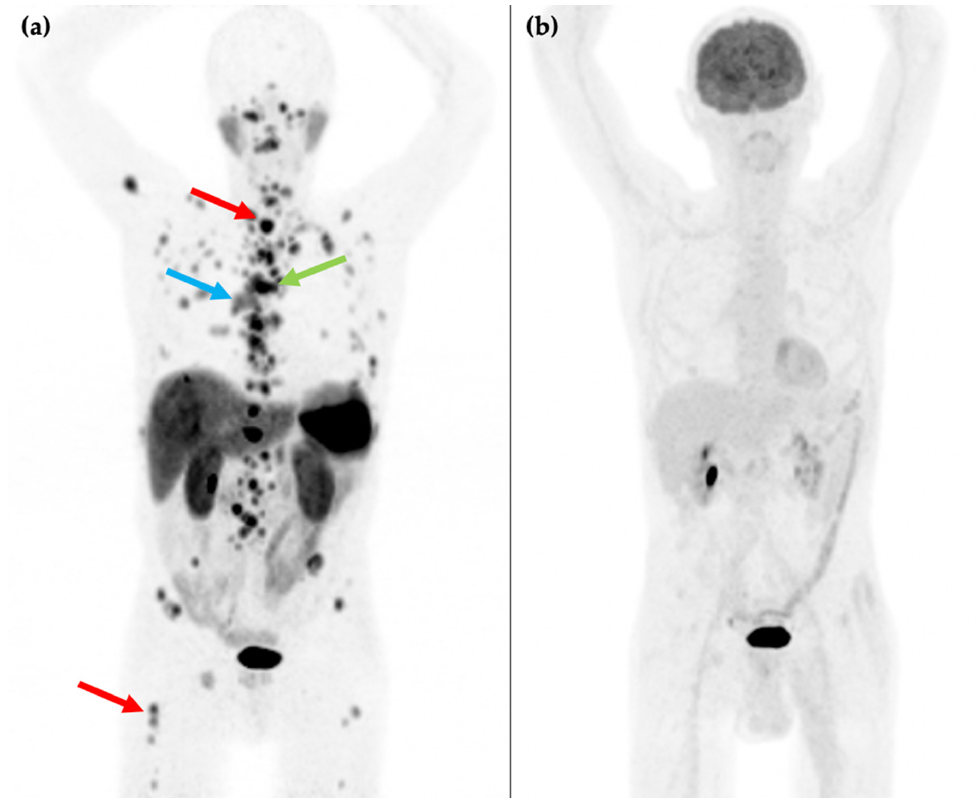
Figure 2. 81-year-old male with an endobronchial lesion identified on conventional CT imaging. 68 Ga-DOTATATE PET/CT MIP image ( a ) shows an SSTR positive right-sided bronchial lesion (blue arrow), mediastinal lymphadenopathy (green arrow), and innumerable bone metastases in the axial and proximal appendicular skeleton including in the spine and right femur (red arrows). 18 F-FDG PET/CT MIP image ( b ) shows that the SSTR positive lesions are not FDG avid. Histology confirmed a G1 typical bronchial carcinoid (Ki-67